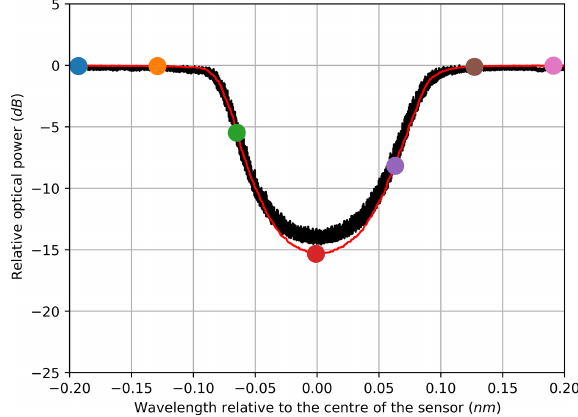
Figure 3. Electrically (red) vs. optically (black) derived filter char- acteristic of an FBG in transmission configuration.